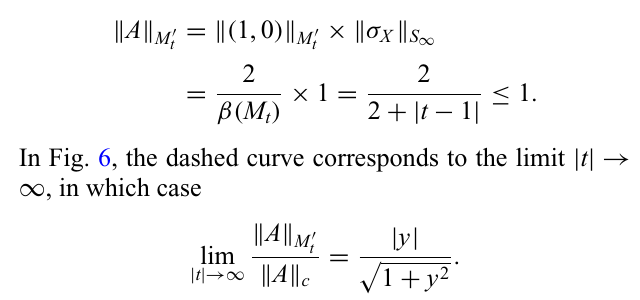
In Fig. 6, the dashed curve corresponds to the limit | t | → ∞ , in which case